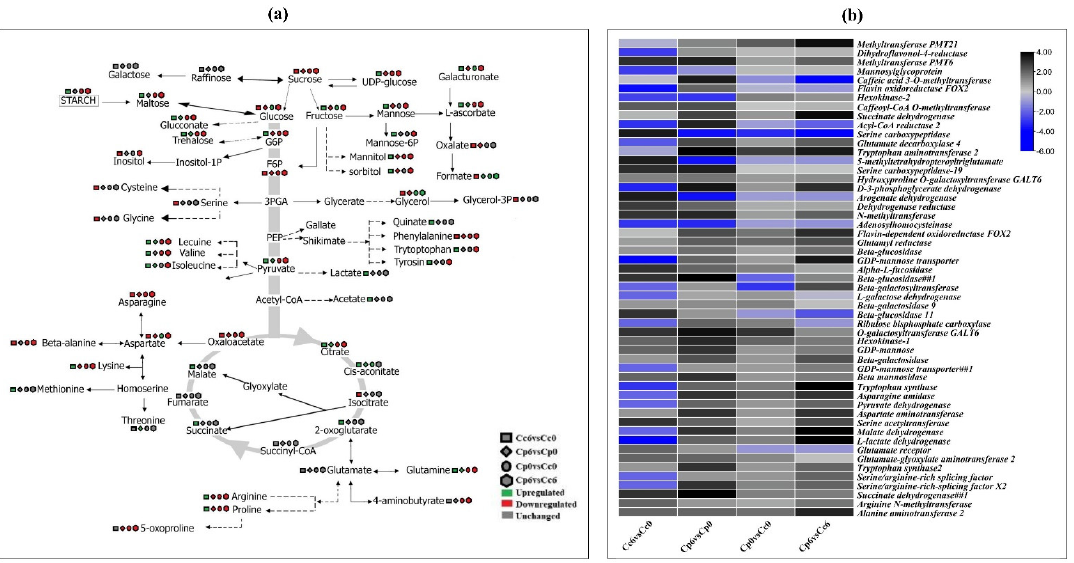
Figure 10. Overview of primary and secondary metabolic pathways during cold stress. ( a ) Changes in the metabolites associated with the pathways after cold stress in C. pubescens and C. chinense seedlings. ( b ) Expression patterns of the genes involved in metabolic pathways after cold stress in C. pubescens and C. chinense seedlings.